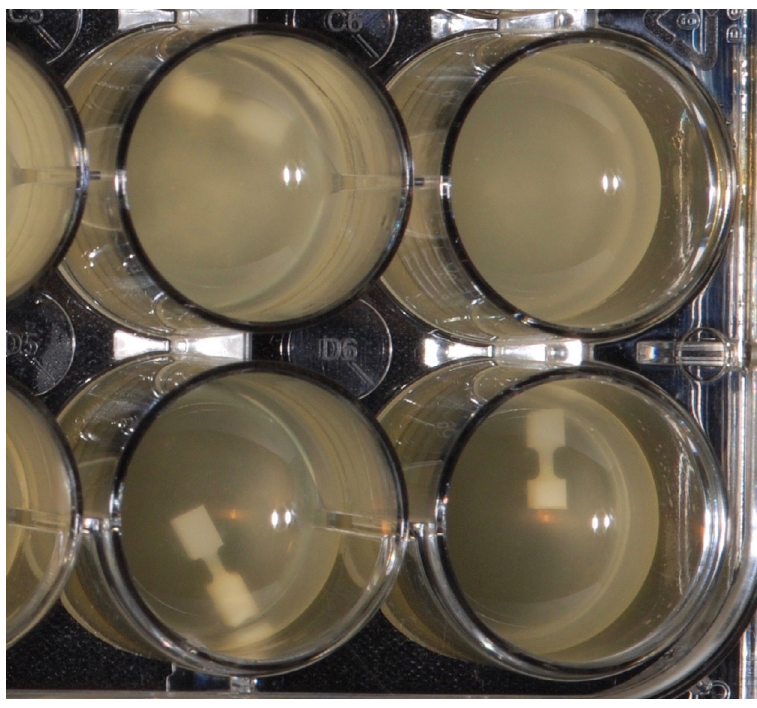
Figure 1- Dumbbells in bacterial aging